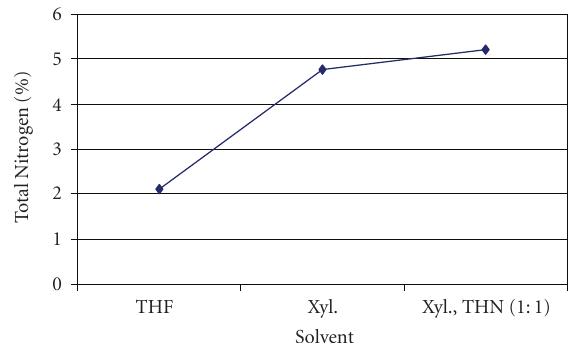
Figure 5: E ff ect of solvent on the nitrogen content after immersing